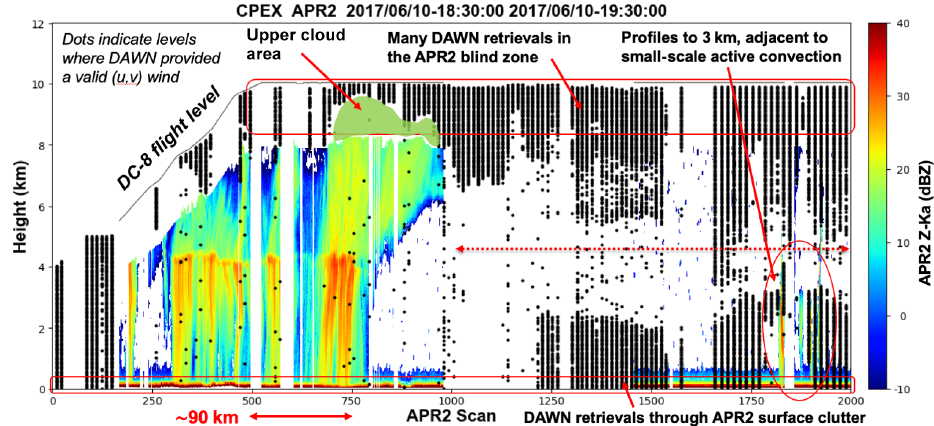
Figure 8. Cross section of the APR-2 Ka-band reflectivity (color scale: dBZ) during segment 1 (18:30–19:30UTC). The x axis represents the APR-2 scan number (2000 scans representing 720km ground distance) and the y axis the MSL height (km). The DC-8 reached its nominal 10km flight altitude near 18:40UTC. The black points represent vertical locations of valid DAWN ( u,v ) wind vectors produced from the DAWN processing of the LOS data. The green shaded “upper cloud” area shows an area where there are clouds in the 1.8km blind zone (where APR-2 does not process data) but whose cloud top is noted in the DAWN profiles above this shaded area.